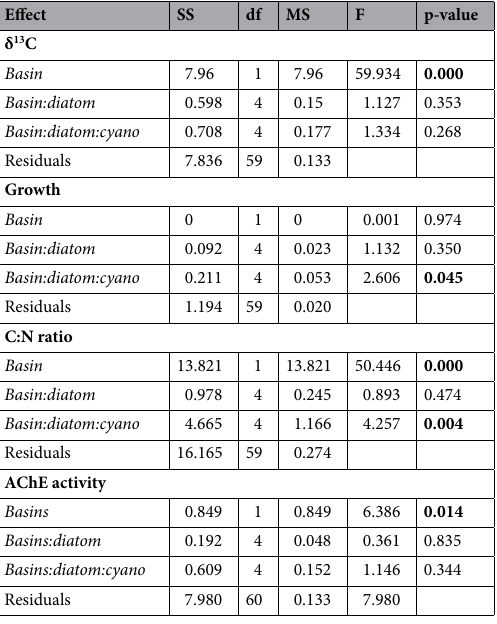
Table 2. Nested ANOVA testing effect of the mixed diet ( cyano ; high/low cyanobacteria proportion), the diatom addition ( diatom ; HD high diatoms, LD low diatoms, S sediment only), and amphipod population origin ( basin ) on the response variables: δ 13 C values, C:N ratio, body mass change relative to the initials (Growth) and Acetylcholinesterase (AChE) activity; see also Figs. 3 and 4. Significant values are in